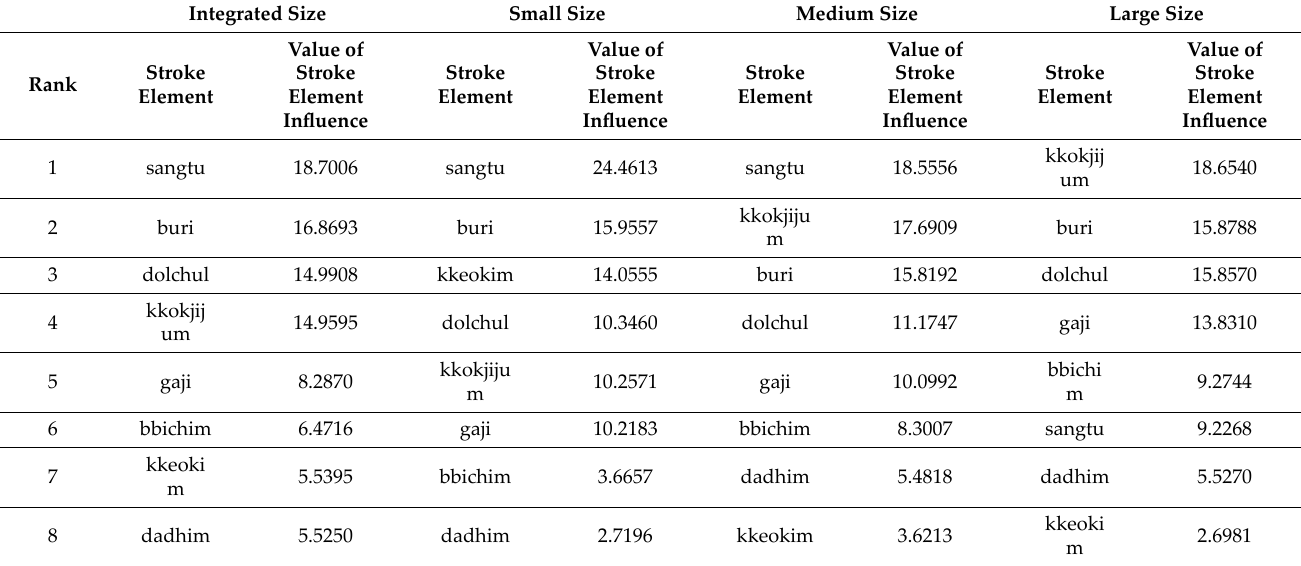
Table 12. Results of converting stroke element influence values into weights.